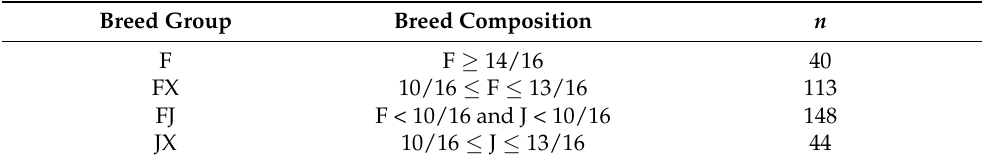
Table 1. Breed composition and number of cows for Friesian (F), Friesian crossbred (FX), Friesian- Jersey crossbred (FJ) and Jersey crossbred